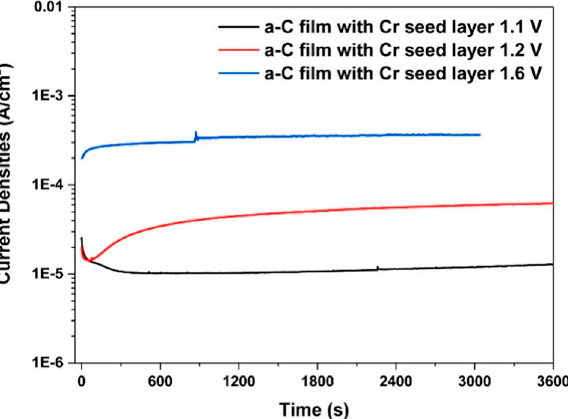
Figure 19. Effect of applied potential on current density of 316L steel coated with amorphous carbon with chromium interlayer. Reprinted from [24] copyright (2017), with permission from Else- vier.